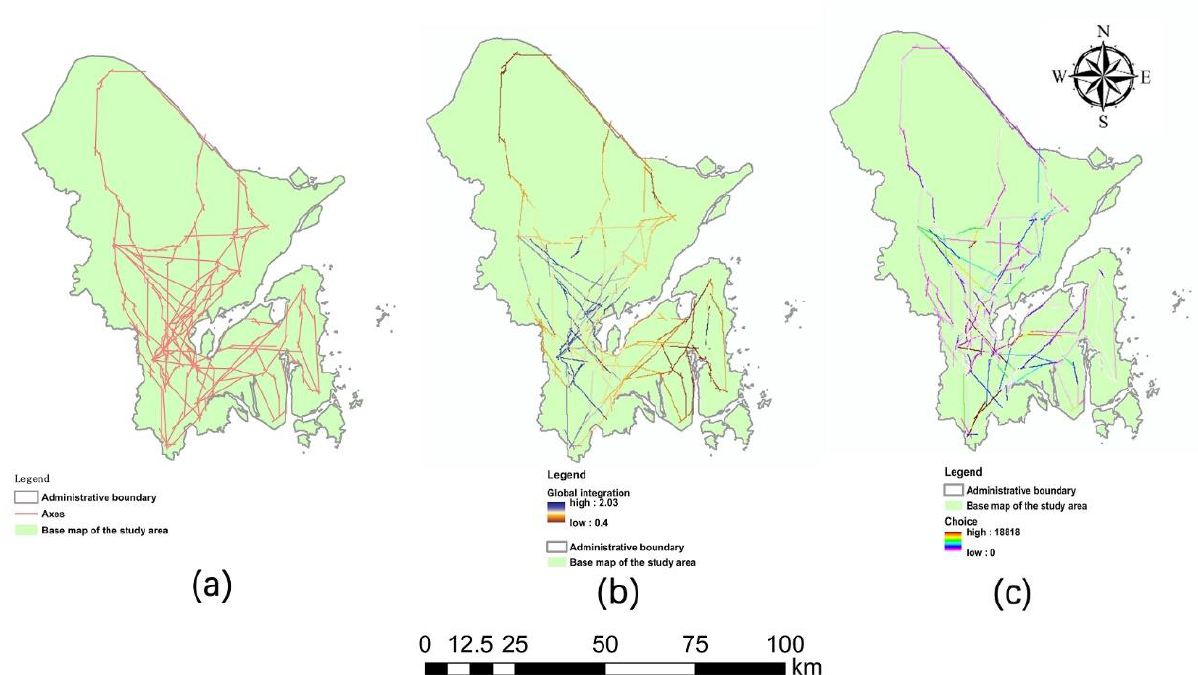
Fig. 6. Column chart of global integration and choice: ( a ) axis choice; ( b ) axis global integration.